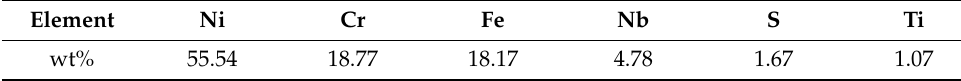
Table 4. Main chemical components of Inconel 718.